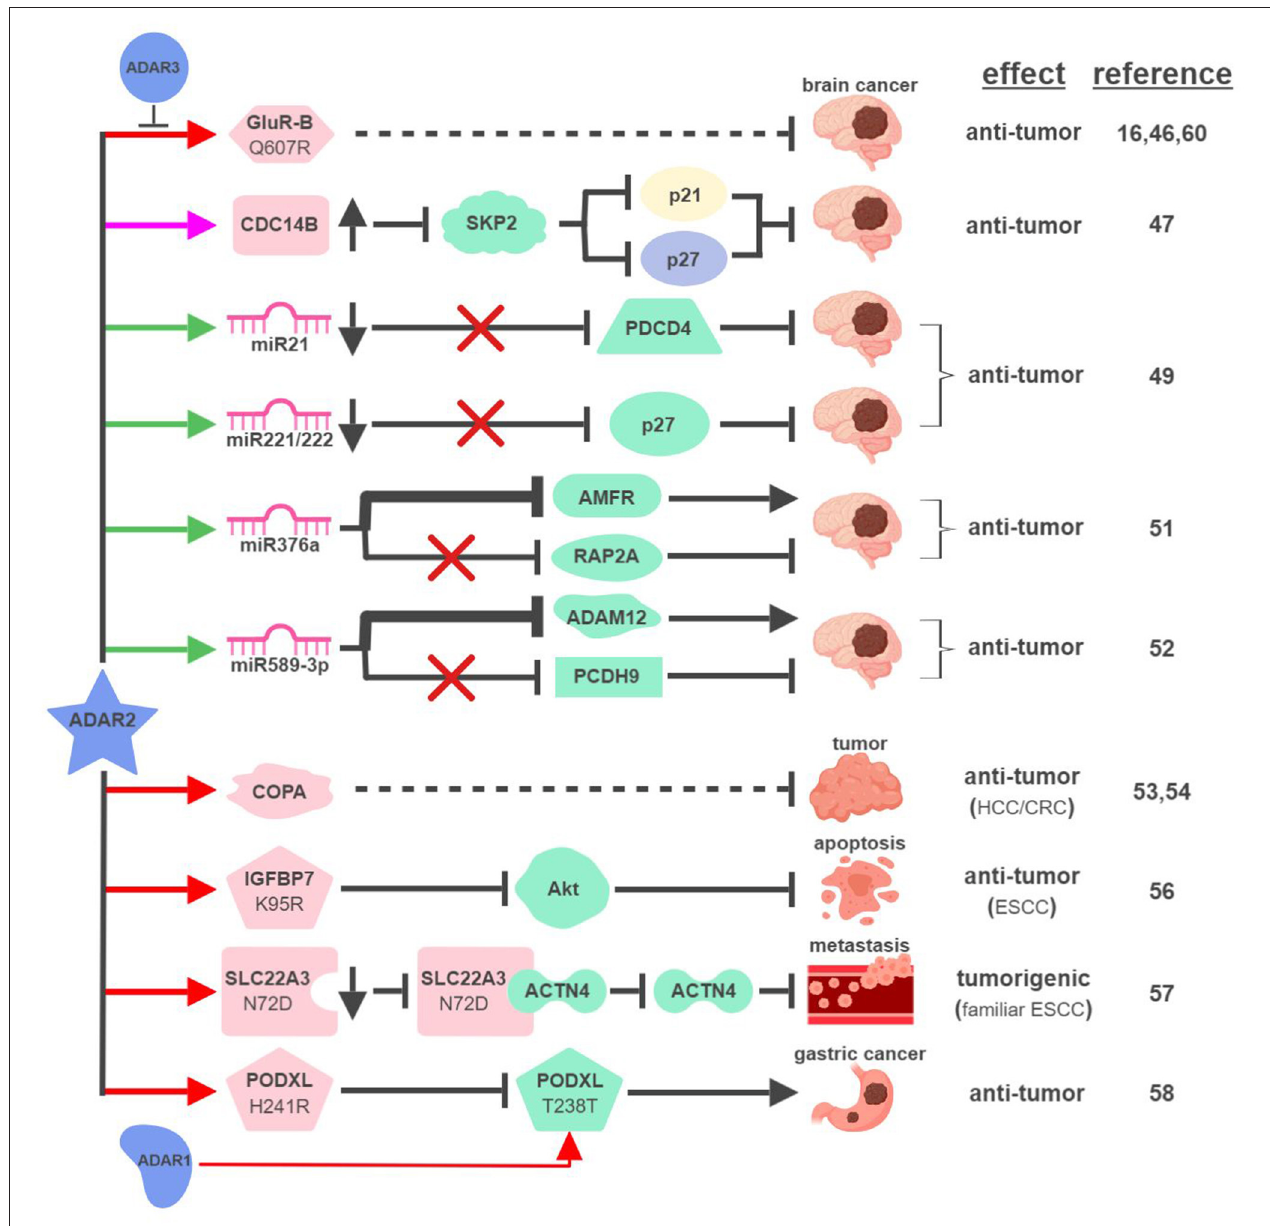
FIGURE 3 | ADAR2-mediated RNA editing in cancer development. The color of the first arrow in each pathway indicates the mechanism (refer to Figure 1 ) by which ADAR2 regulates its direct targets, depicted in pink icons or shapes. Dashed lines indicate suggested/unproven functions/relationships. Specific diseases and phenotypes/functions affected by ADAR2-mediated RNA editing are only labeled in the first appearance (ex. brain cancer). HCC, hepatocellular carcinoma; ESCC, esophageal squamous cell carcinoma; CRC, colorectal cancer. The figure was created with